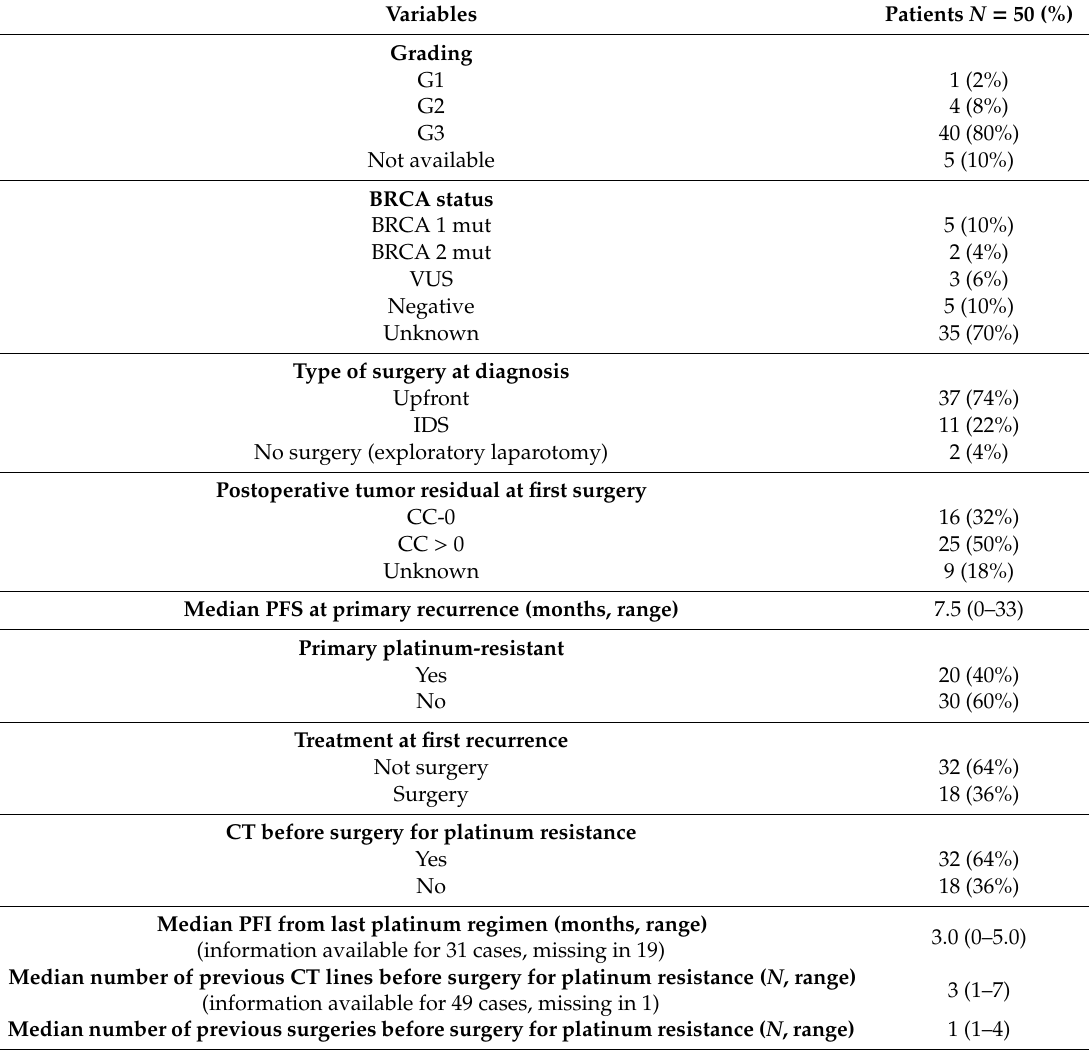
Legend: N = number; FIGO = International Federation of Gynecology and Obstetrics; BRCA = breast cancer; VUS = variant of unknown significance; IDS = interval debulking surgery; LPT = laparotomy; CC = completeness of cytoreduction; PFS = progression-free survival; CT = chemotherapy; PFI = platinum-free interval at first